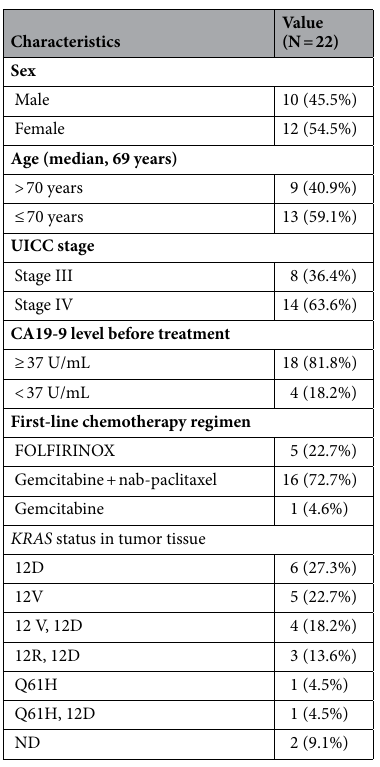
Table 1. Characteristics of patients who underwent chemotherapy. Data are presented as n (%). UICC, Union for International Cancer Control; CA19-9, carbohydrate antigen 19-9; FOLFIRINOX, folinic acid, fluorouracil, irinotecan, and oxaliplatin; ND, not